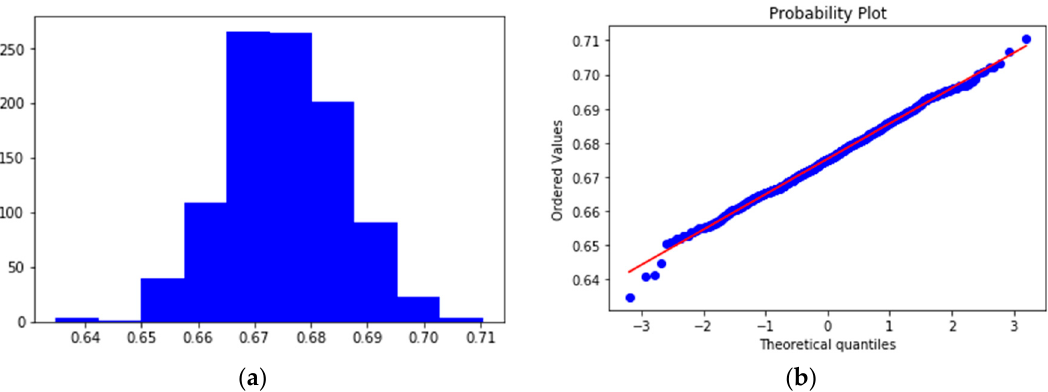
Figure 2. Uncertainly analysis at 60 days of leaching, copper recovery distribution ( a ) and normal probability plot ( b ).